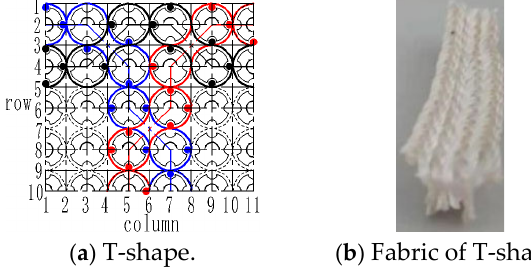
Figure 9. Three ‐ track combination of 484 cross ‐ break track and its fabric. Figure 9. Three-track combination of 484 cross-break track and its